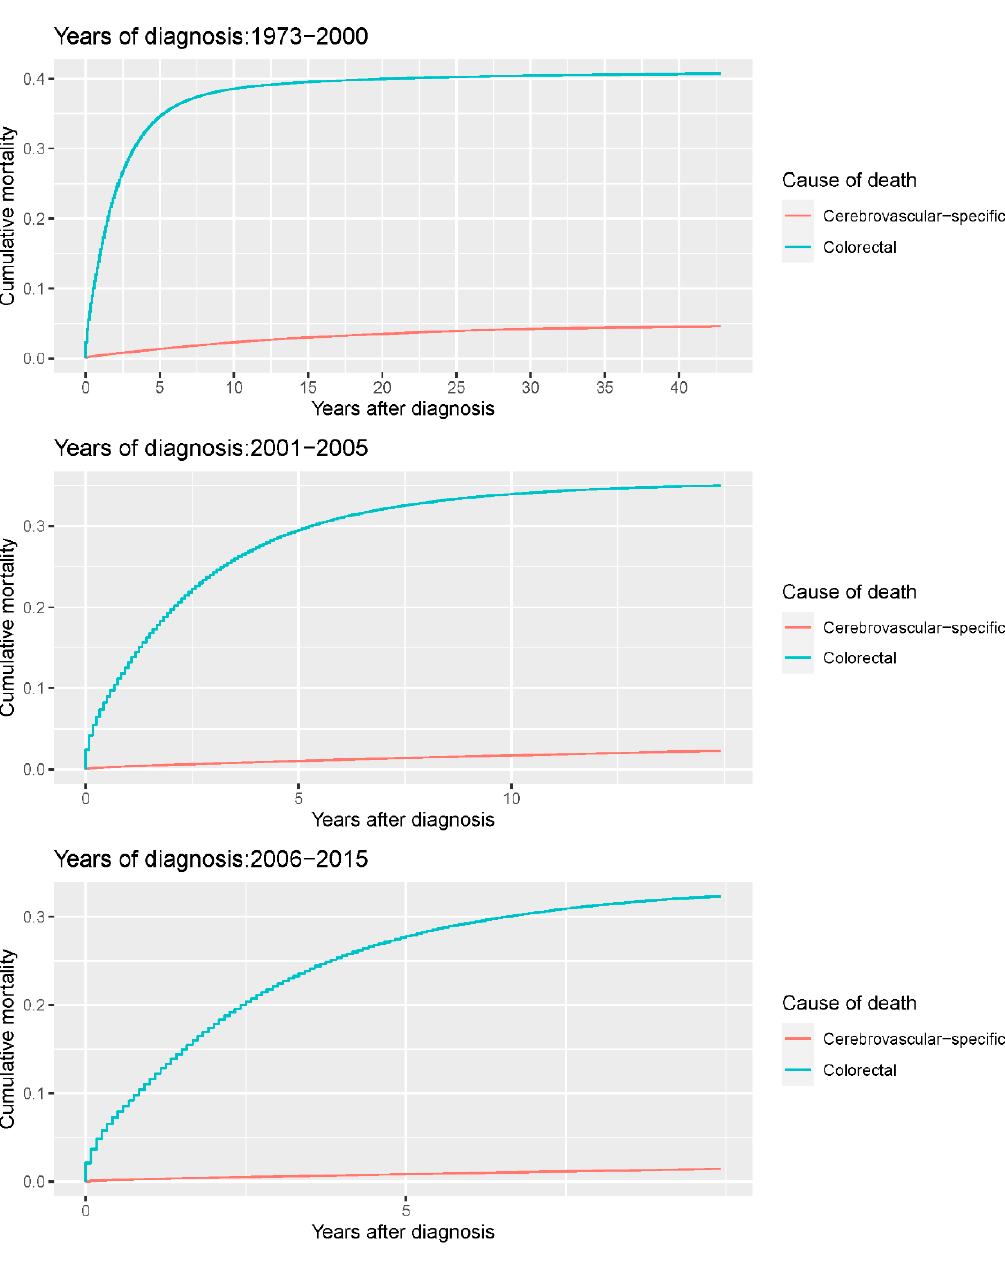
Figure 4. Cumulative cerebrovascular-specific and colorectal cancer-specific mortality stratified by year at diagnosis. Univariate analyses using a competing risk model were performed to test the relationship between year of diagnosis and CVSM in CRC patients ( p < 0.0001), and differences in cumulative mortality among different subgroups were analyzed by Gary’s test.